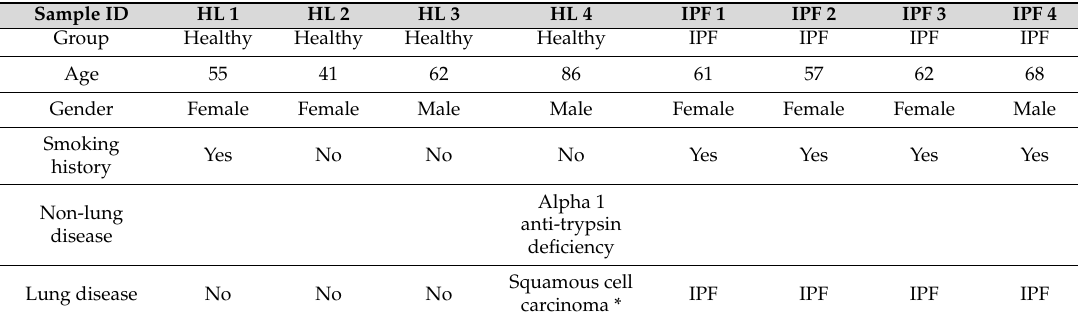
Table 1. Patient and donor tissue